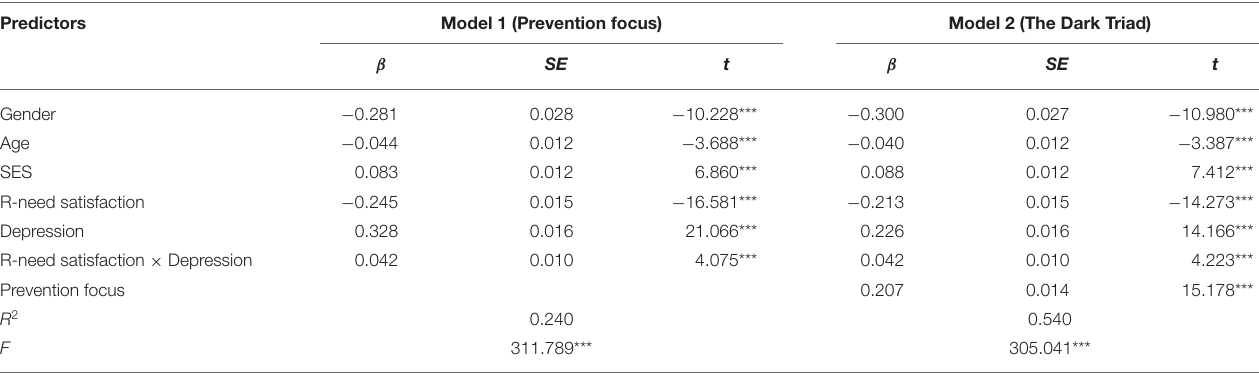
TABLE 2 | Regression testing of the moderated mediation